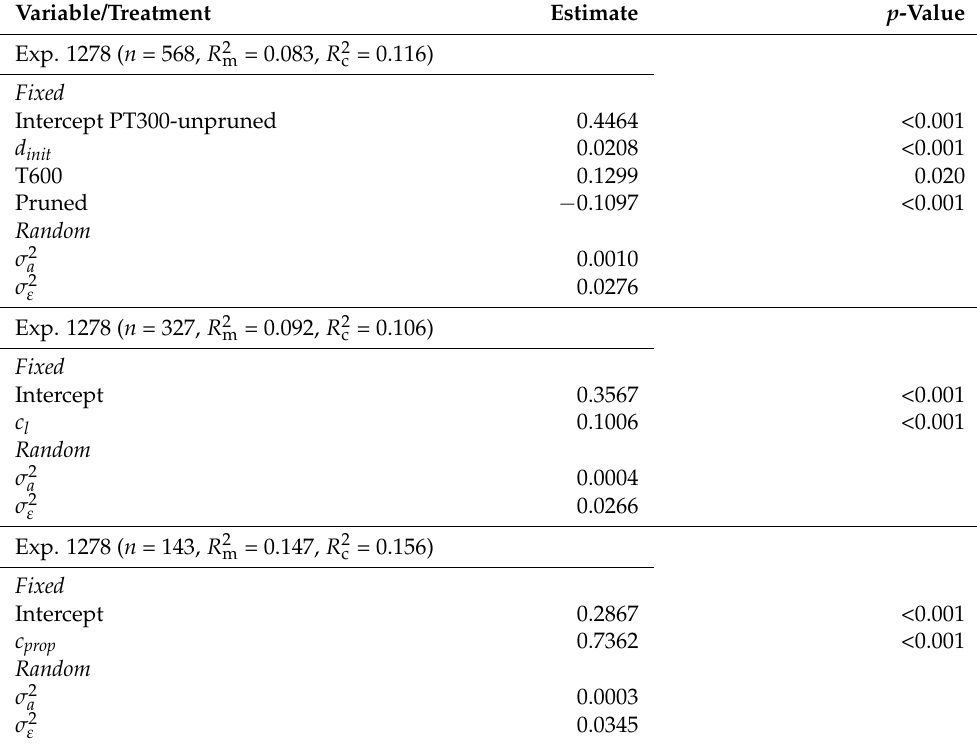
Table 7. Parameter estimates for the final model of individual crop tree growth on dbh. Legend: d init = initial stem dbh, c l = remaining crown length, c prop = remaining crown proportion, n = number of observations, R 2 m = marginal coefficient of determination concerned with variance explained by fixed factors, R 2 c = conditional coefficient of determination concerned with variance explained by both fixed and random effects, σ 2 α = variance attributed to plot, σ 2 ε = residual variance.